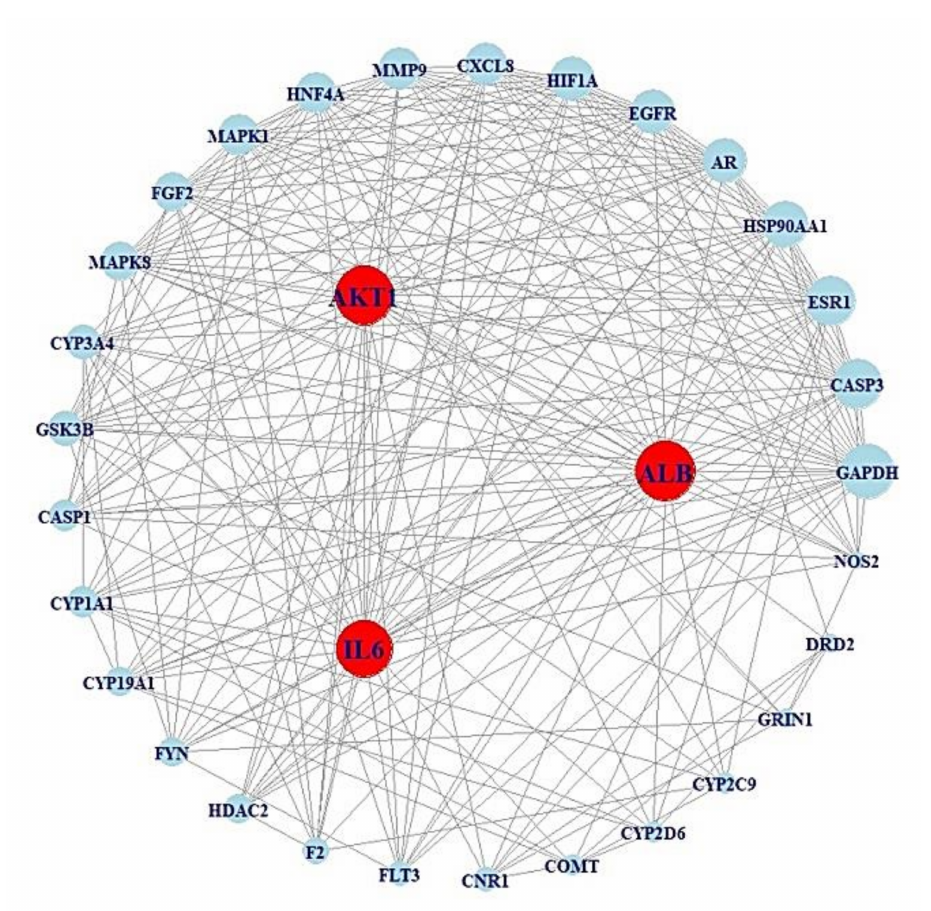
Figure 3. PPI networks (32 nodes, 254 edges) of the top 30% BC values from Figure 3. Five metabolites (equol, 3-indolepropionic acid, trimethylamine oxide, butyrate, and acetate) on IL6 (PDB ID: 4NI9) and one metabolite (indole) on AKT1 were selected to perform MDT (Table 4). We observed that the equol–IL6 complex (-7.4 kcal/mol) (Figure 5) docked most stably, indicating its promise as a postbiotic and a target. Table 4. Molecular docking test of IL6 (PDB ID: 4NI9) and AKT (PDB ID: